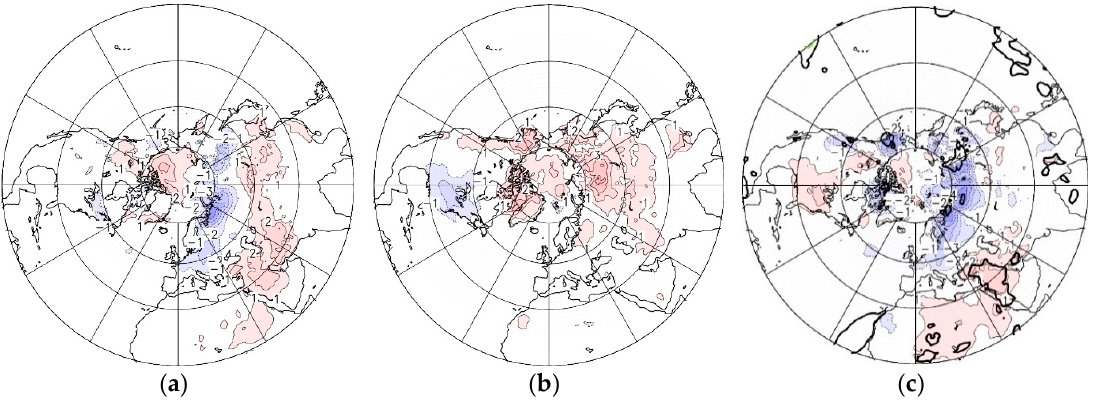
Figure 10. Same as Figure 9 for mean 2 m (above surface) temperature anomaly (K).